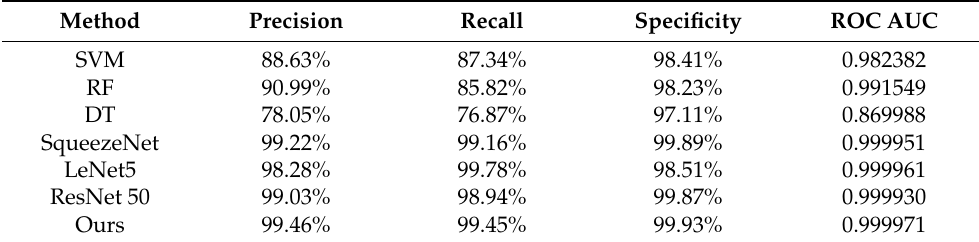
Table 11. The comparison results for imbalanced training dataset